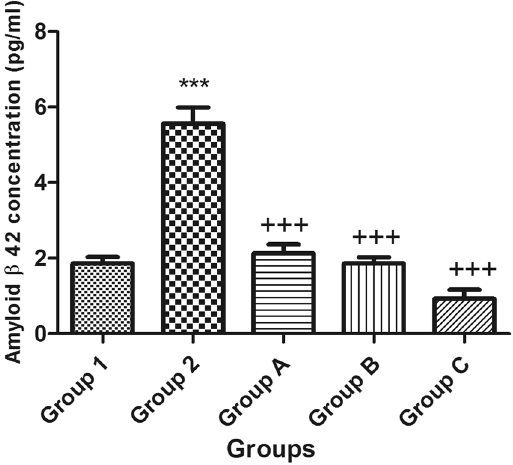
Figure 4. Effect of STZ, celecoxib, and gingerol (10 and 20 mg/kg) on the mean mouse amyloid beta 42 concentration using an ELISA assay. Animals were divided into 5 groups. Group 1 received a single ICV dose of saline; then, after 2 weeks, animals were intraperitoneally injected with saline for seven days. Group 2 received a single injection of STZ (3 mg/kg, i.c.v.), and then, after 2 weeks, they were intraperitoneally injected with saline for 7 days. Group A was injected with STZ (3 mg/kg, i.c.v.) once, and after 2 weeks, they were injected with celecoxib (30 mg/kg, i.p.) for 7 days. Group B animals were injected with STZ (3 mg/kg, i.c.v.) once, and after 2 weeks, they were injected with gingerol (10 mg/kg/day, i.p.) for 7 days. Group C was injected with STZ (3 mg/kg, i.c.v.) once, and after 2 weeks, they were injected with gingerol (20 mg/kg/day, i.p.) for 7 days.